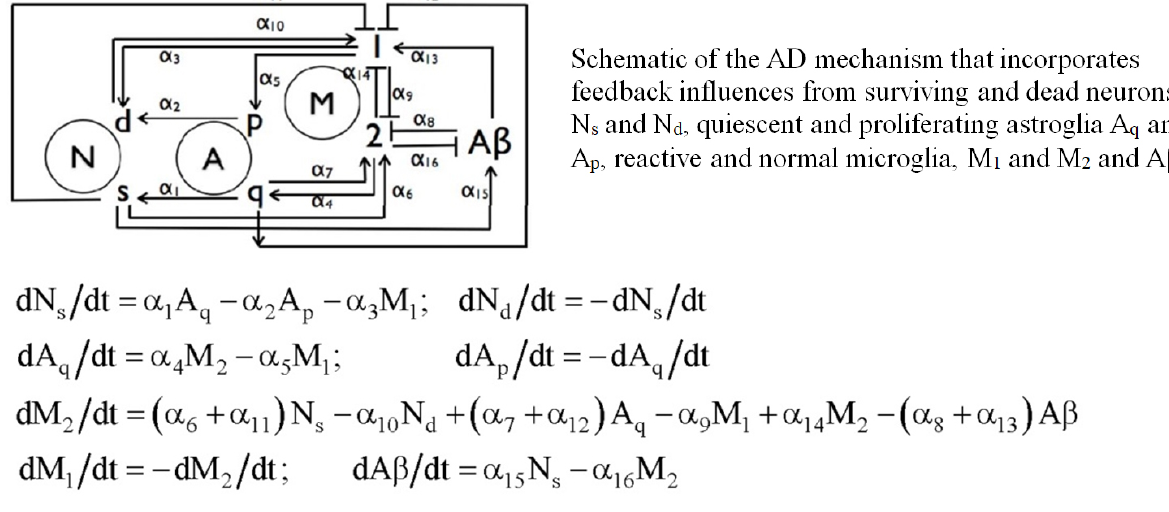
Figure 5: Mathematical model consisting of 7 kinetic equations for brain cell populations and A β amyloid protein. For related details of model development and numerical solutions the reader can consult [14].